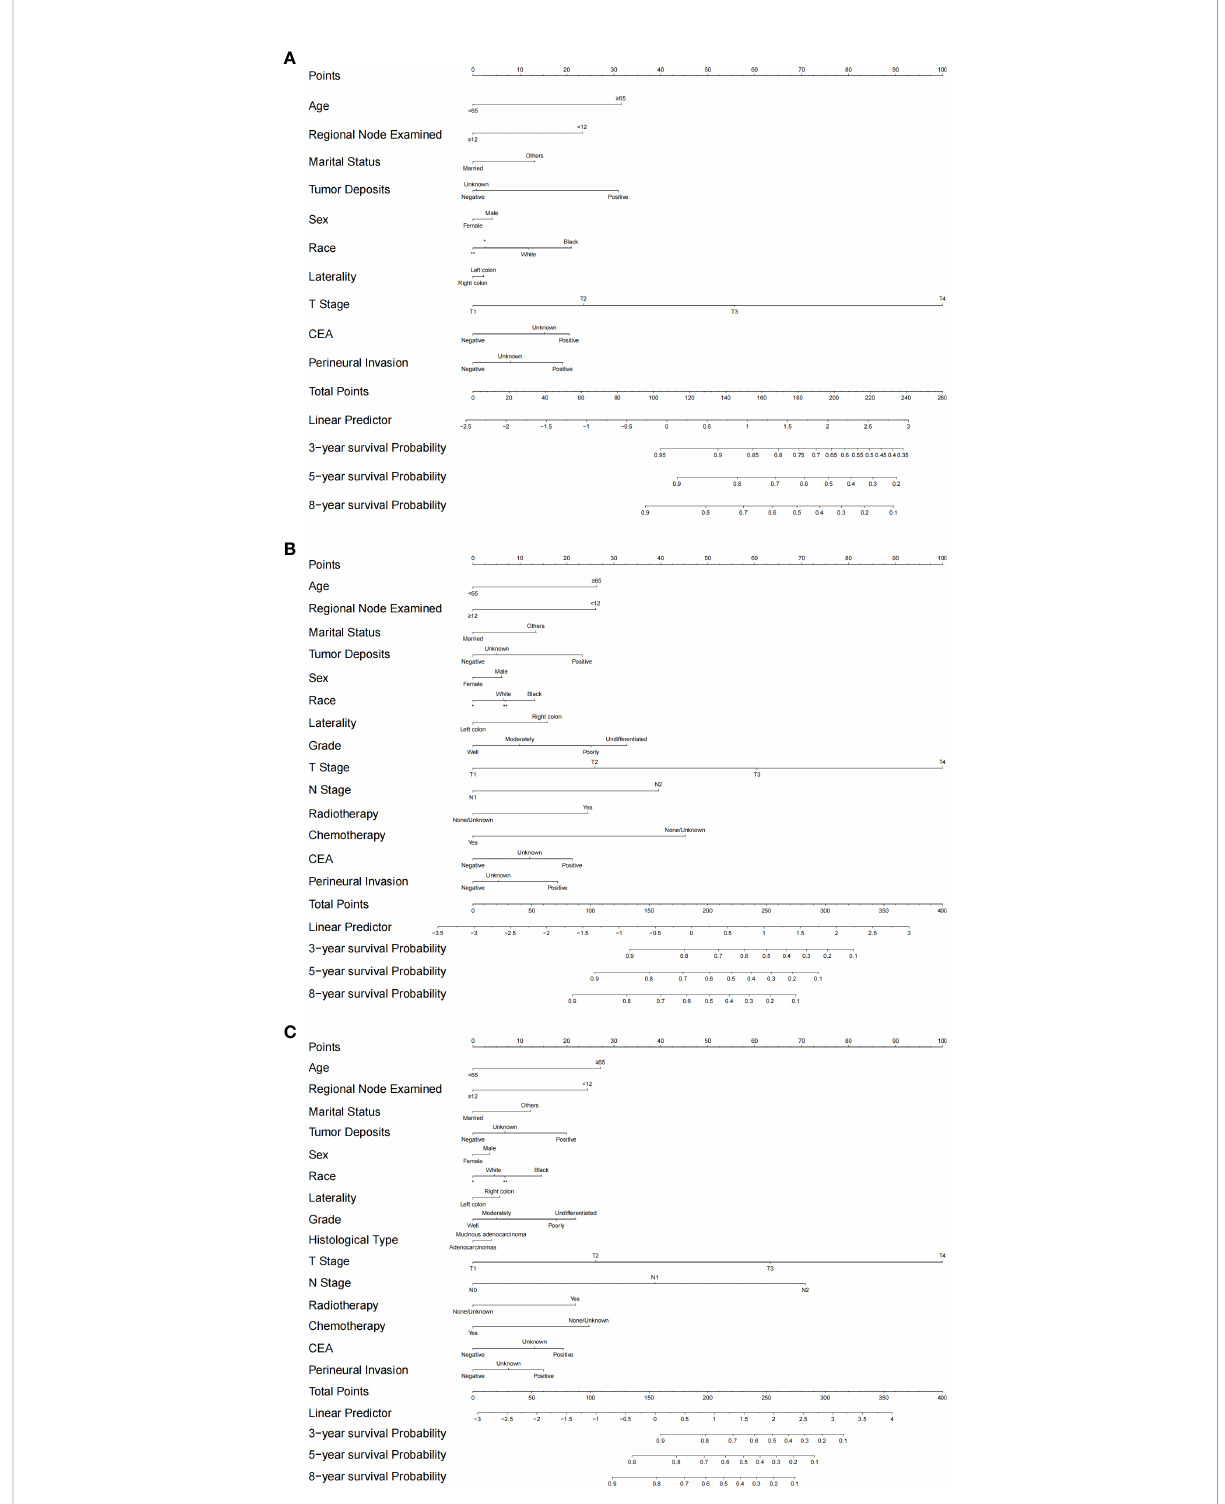
FIGURE 4 Established nomograms for optimal models for stage I/II, stage III and all-stage groups. (A) nomogram for stage I/II; (B) nomogram for stage III; (C) Nomogram for all stages. *: Asian or Paci fi c Islander; **: American Indian/Alaska